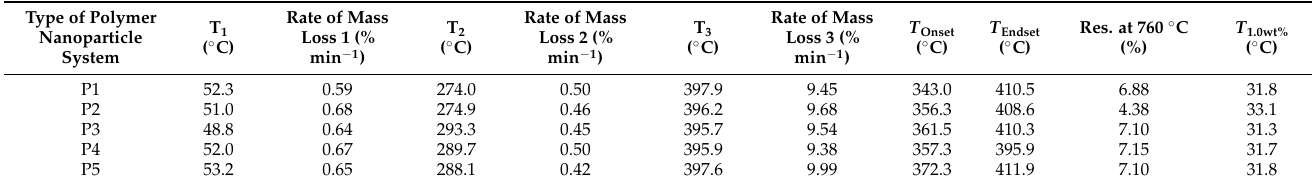
Table 2. The results of the TG and DTG curve analyses of